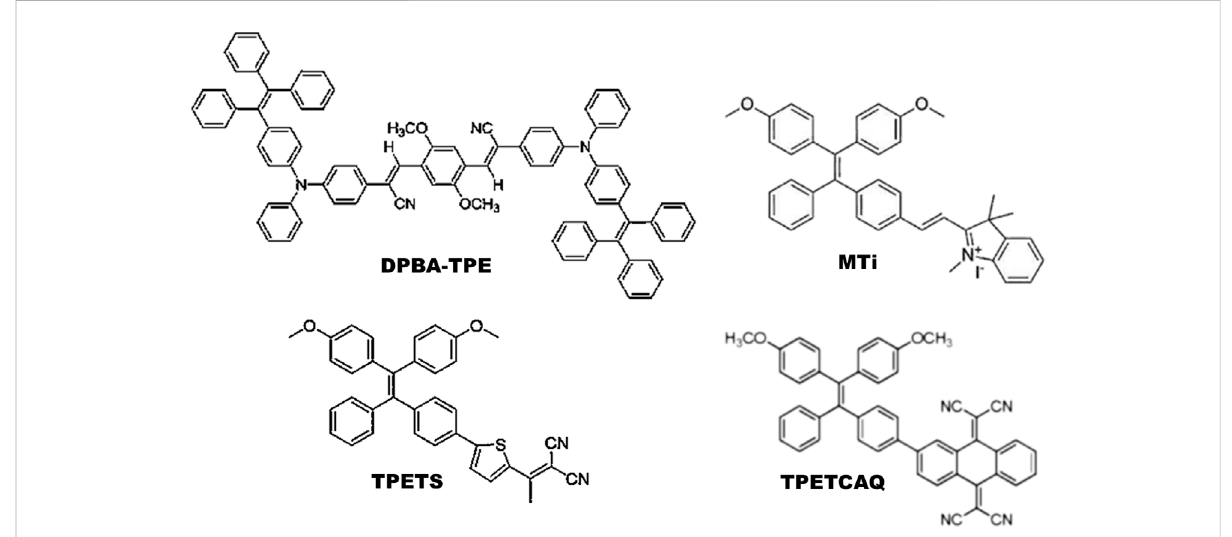
FIGURE 3 Illustrations for Donor-AIE(neutral)-Acceptor photosensitizers: In general, these are constructed on a tetraphenylethene (TPE) cytoskeleton. Alternatively, tetraphenylamine (TPA) can act as an electron donor and/or core of the AIE-photosensitizer. Source: DPBA-TPE (Feng et al., 2015a), MTi (Chen et al., 2019), TPETS (Gao et al., 2019a), TPETCAQ (Wu et al., 2017a). Please refer Tables 2 – 5 for